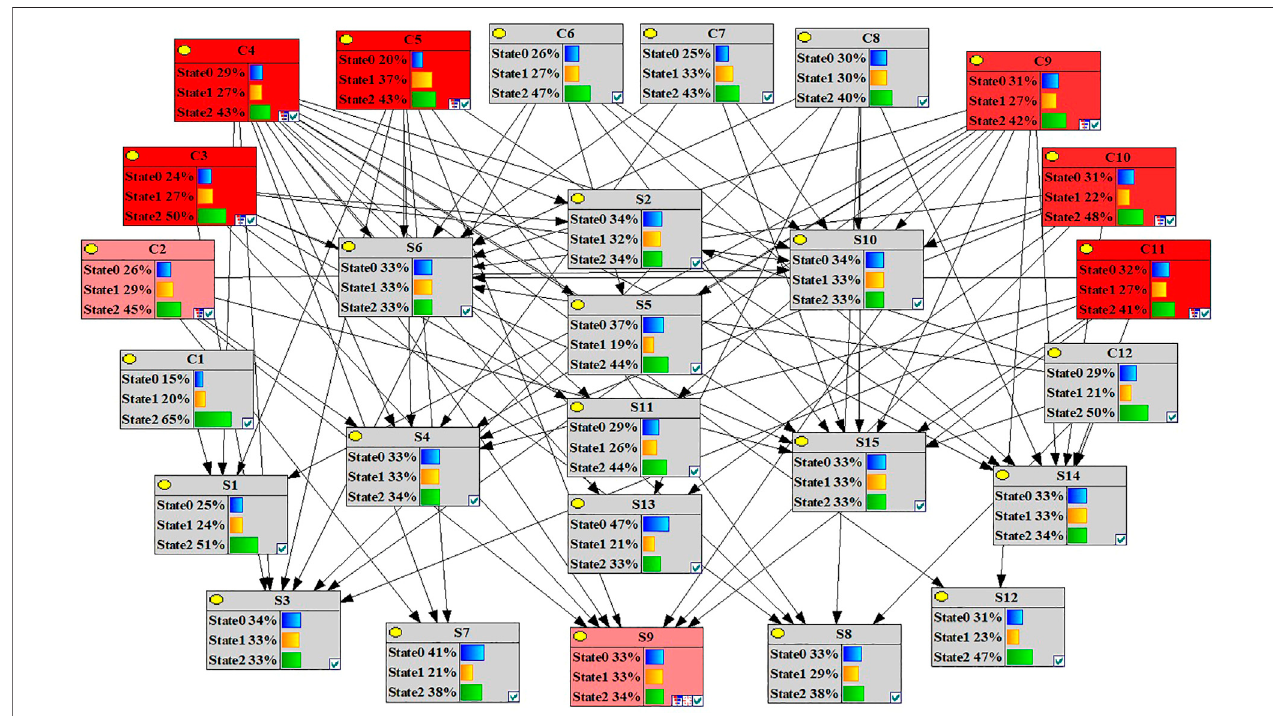
FIGURE 6 | Sensitivity analysis results of the case study.